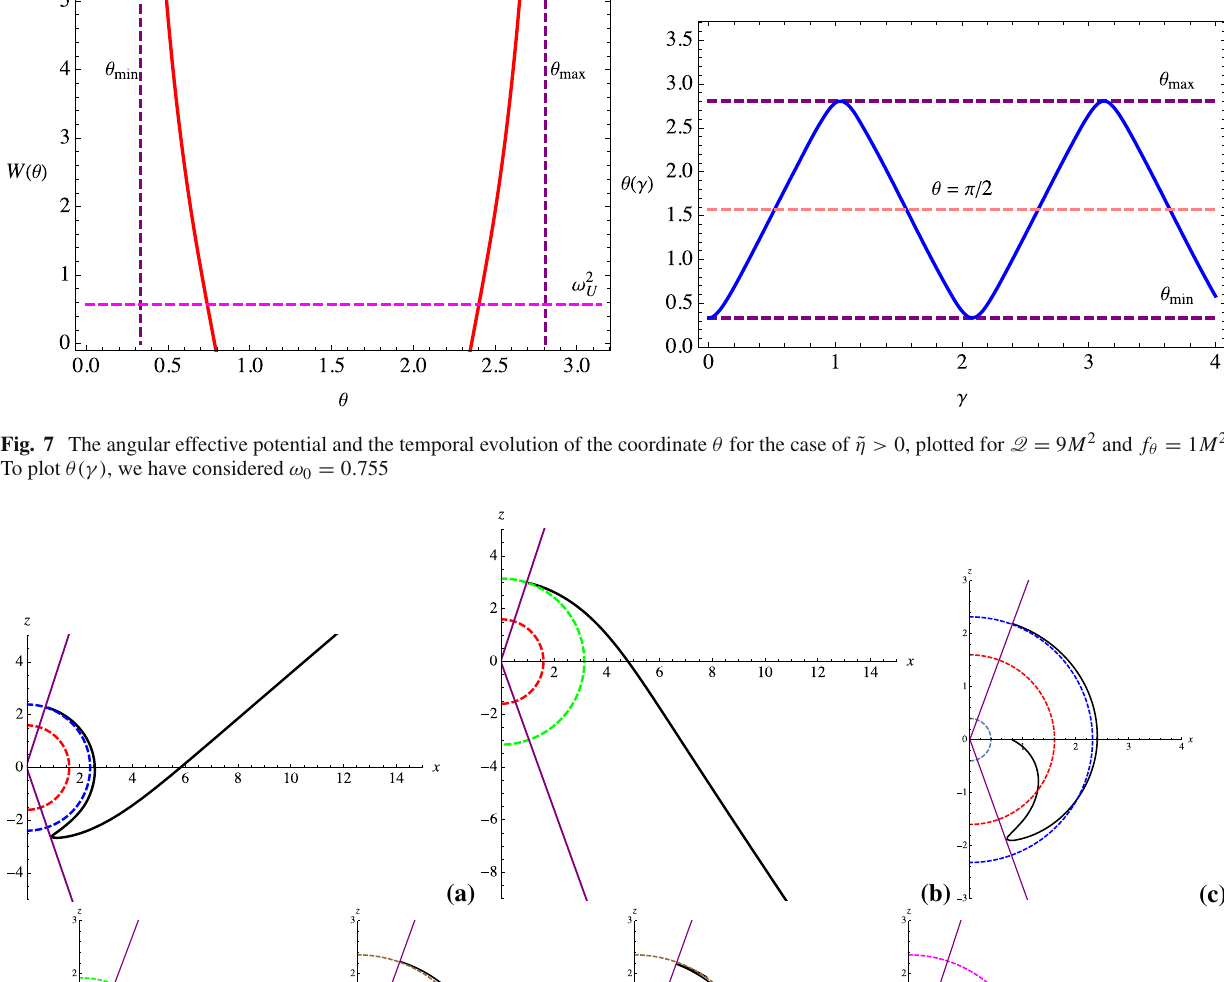
(b) DFK for ω 0 = 0 . 70, (c) DSK for ω 0 = 0 . 755, (d) DSK for ω = 0 . 70, (e) UCOFK, (f) UCOSK, and (g) radial capture for ω 0